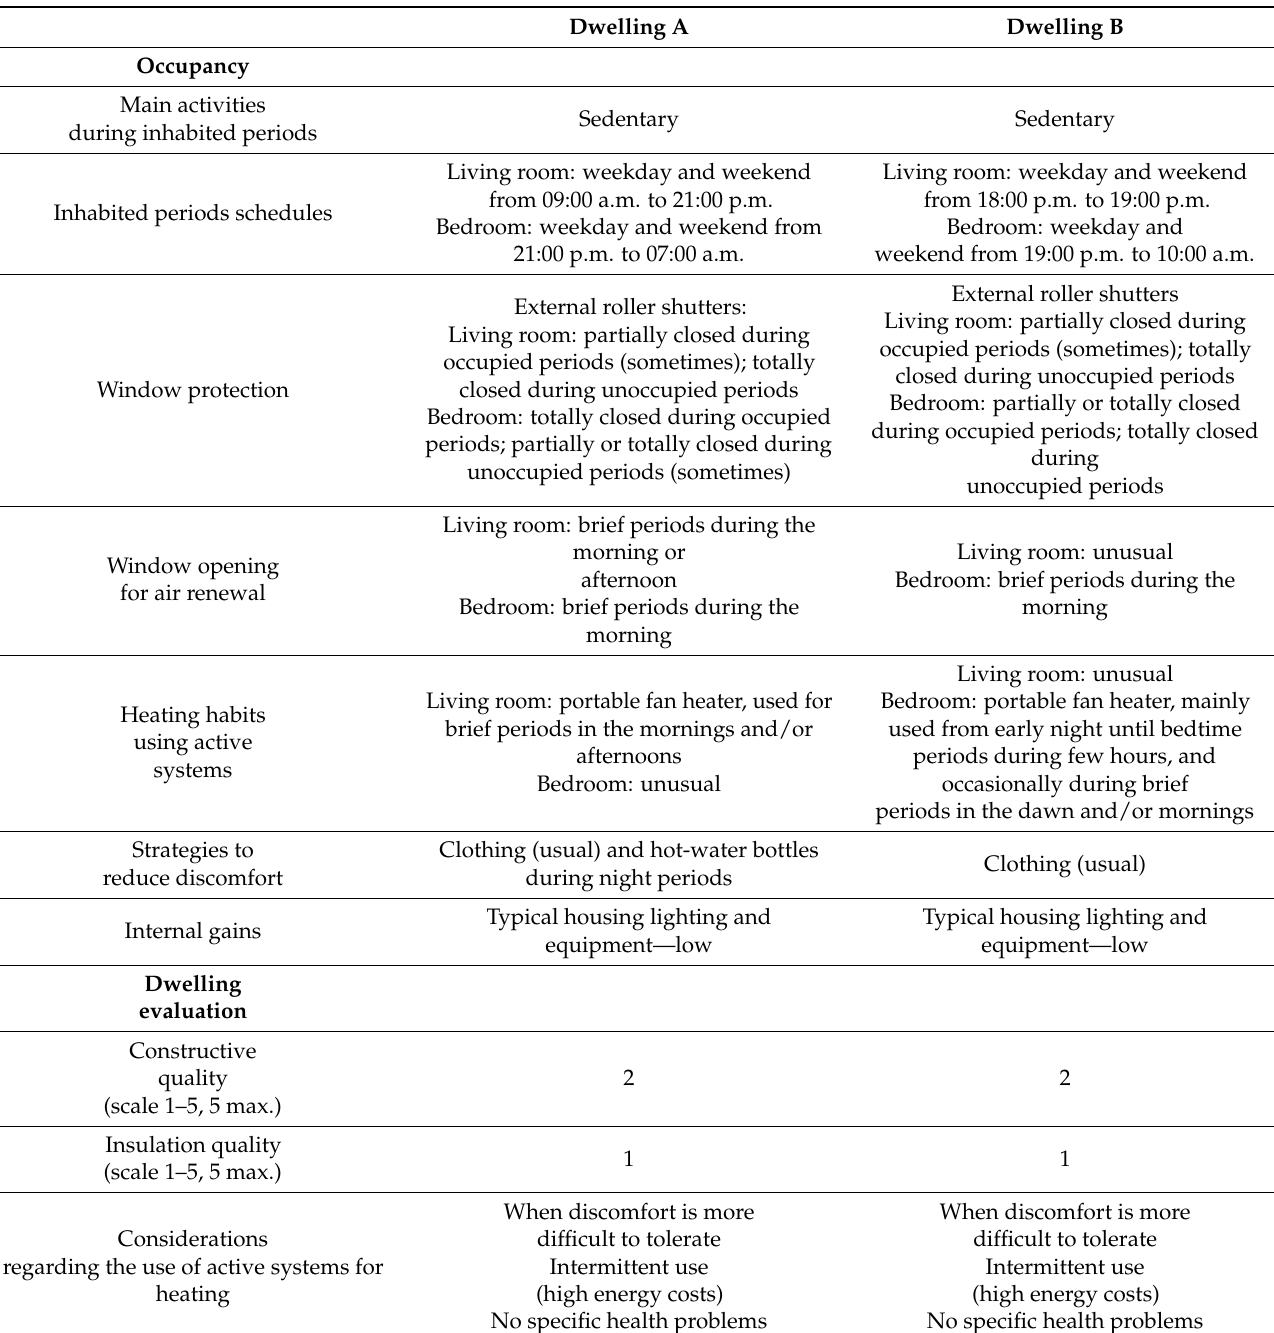
Table 3. Qualitative data obtained from questionnaires to